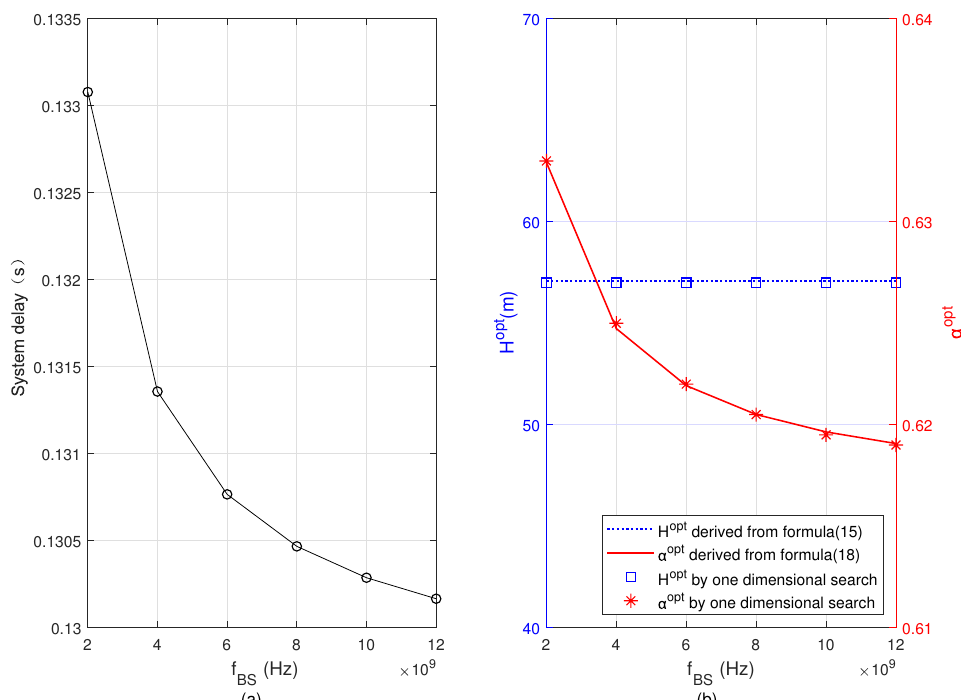
Figure 9. Minimum system delay, optimal flying altitude, and optimal task allocation ratio versus the CPU frequency allocated for computation on the BS. ( a ) Minimum system delay, ( b ) optimal flying altitude and optimal task allocation